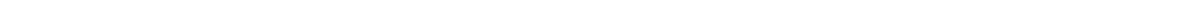
Figure 4 | Chd7 is required for activation of neuronal genes during GNP differentiation. ( a ) qRT–PCR analysis of Chd7 transcripts in P7 Chd7 WT [ Chd7 f/f ], heterozygous [ Atoh1-Cre::Chd7 f/ þ ] and homozygous [ Atoh1-Cre::Chd7 f/f ] mutant GNPs. The level of Gapdh transcripts was used for normalization. Bars represent normalized mean value ± s.d. from three samples for each group. Paired two-tailed t -test with equal variance was performed, P ¼ 0.0034 (for Het.); P ¼ 0.001 (for Hom.). ( b ) Heatmap shows significantly downregulated genes ( P o 0.01, the Kruskal–Wallis test) in Chd7 mutant GNPs compared to WT. The colour scale is shown on the right. ( c ) DAVID Gene Ontology Biological Process analysis of genes downregulated in Chd7 homozygous mutant GNPs compared to WT. GO terms with Benjamini adjusted P -value o 0.05 are shown. ( d ) Heatmap exhibits significantly downregulated genes that are involved in neural function, in Chd7 mutant GNPs compared to WT. The colour scale is shown on the right. ( e ) ChIP-seq density heatmaps for Chd7 and H3K27ac within ± 5kb of the Chd7 peak centre. ( f ) ChIP-seq density heatmaps show the enriched binding of Chd7 to super-enhancers (SEs) defined by H3K27ac. The start (S) and end (E) of SEs and ± 5kb surrounding the enhancer regions are shown. ( g ) IGV track view of ChIP-seq density profile for Chd7 and H3K27ac of Neurod1 and Cadps2 . The SE region is highlighted with red line. ( h ) IGV track view of ATAC-seq density profile (normalized to per million reads for each sample) at Cadps2 and Nkain3 . The decreased ATAC-seq peaks are highlighted with grey